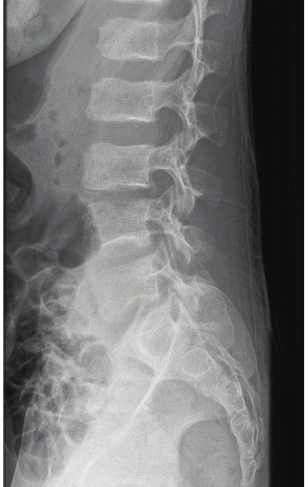
Figure 4: Lateral radiograph of the lumbar spine 4 days after the surgery shows L3-L4 disk space narrowing with erosion of the inferior endplate of L3 and superior endplate of L4.